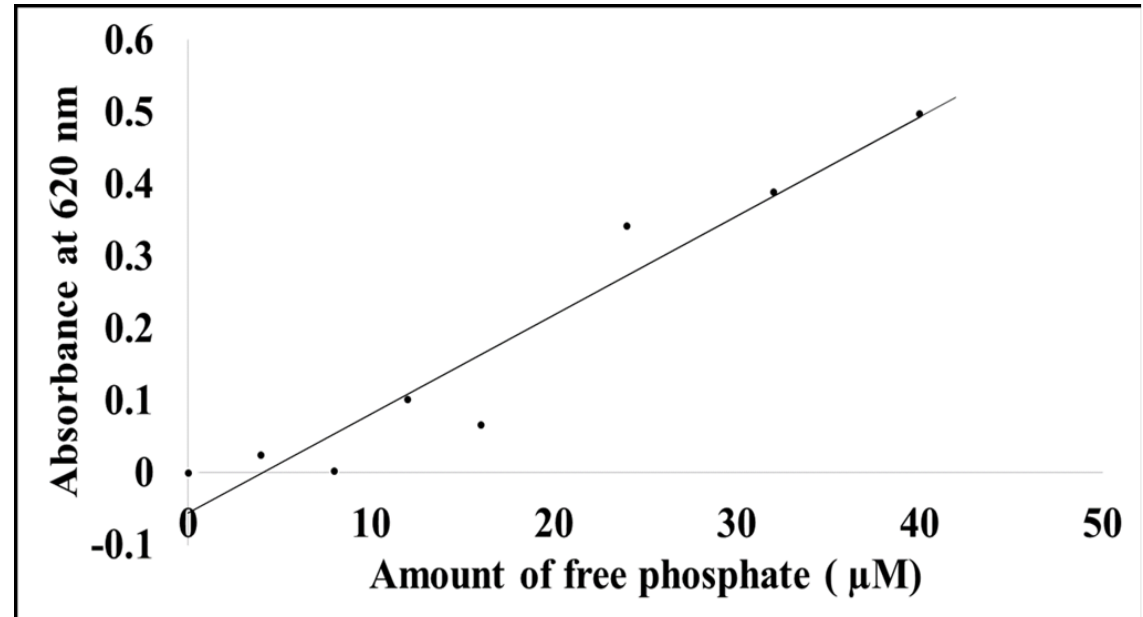
Figure 6. Standard curve showing the varying amount of free phosphate released at 620